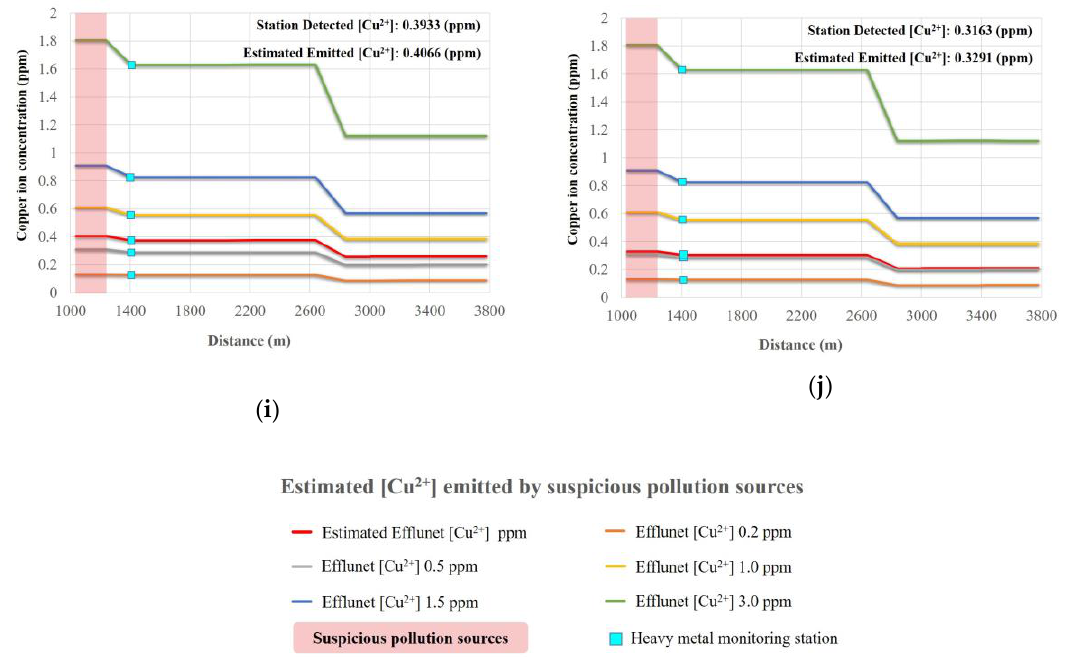
Figure 10. Reverse prediction of Cu 2+ concentrations along the channel for each case at heavy metal monitoring station M02 ( a ) 0.358 ppm, ( b ) 0.595 ppm, ( c ) 0.482 ppm, ( d ) 0.429 ppm, ( e ) 0.299 ppm, ( f ) 0.271 ppm, ( g ) 0.209 ppm, ( h ) 0.226 ppm, ( i ) 0.393 ppm, and ( j ) 0.316 ppm.